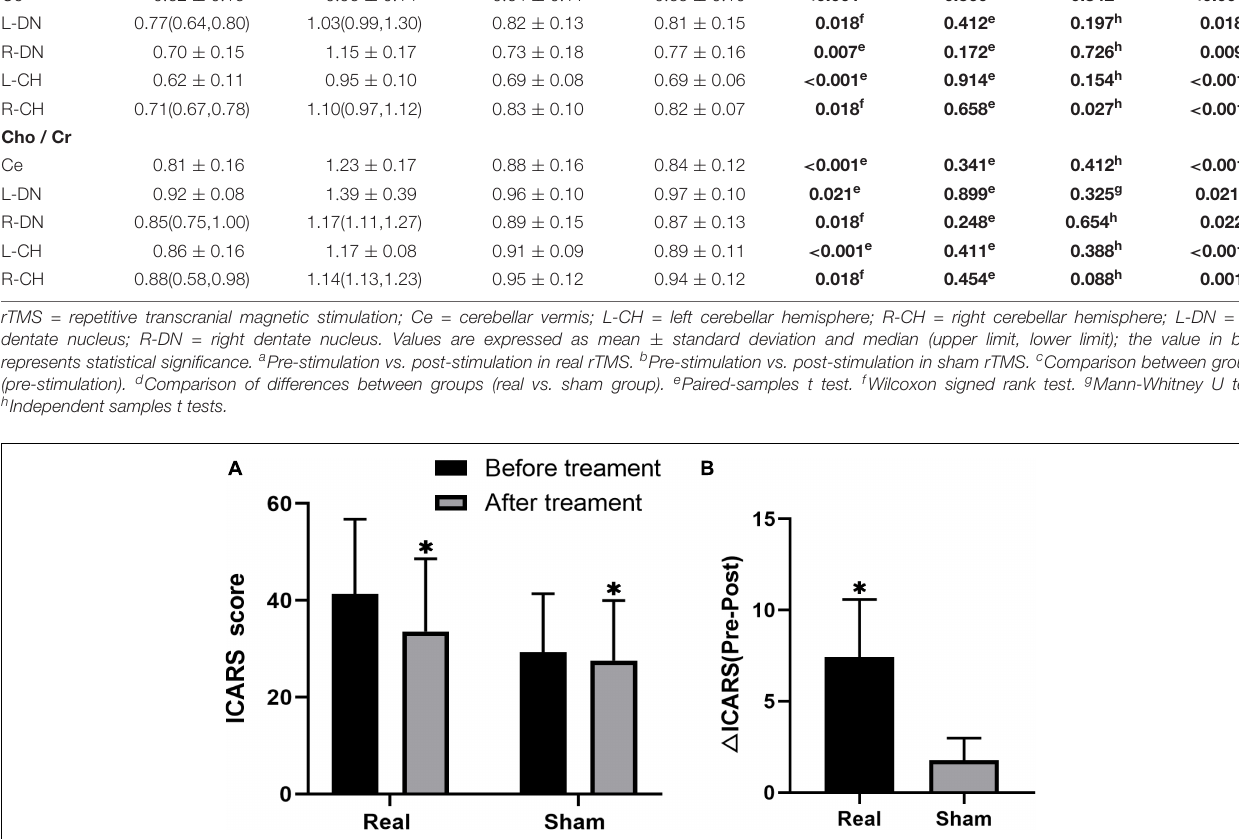
FIGURE 2 | Changes in ICARS score before and after treatment in both groups of real and sham stimulation. The comparison between pre and post stimulation in both groups, respectively (A) .The comparison of difference in ICARS ( (cid:77) ICARS) after the stimulation between real and sham stimulation groups (B) . *Indicates the significant